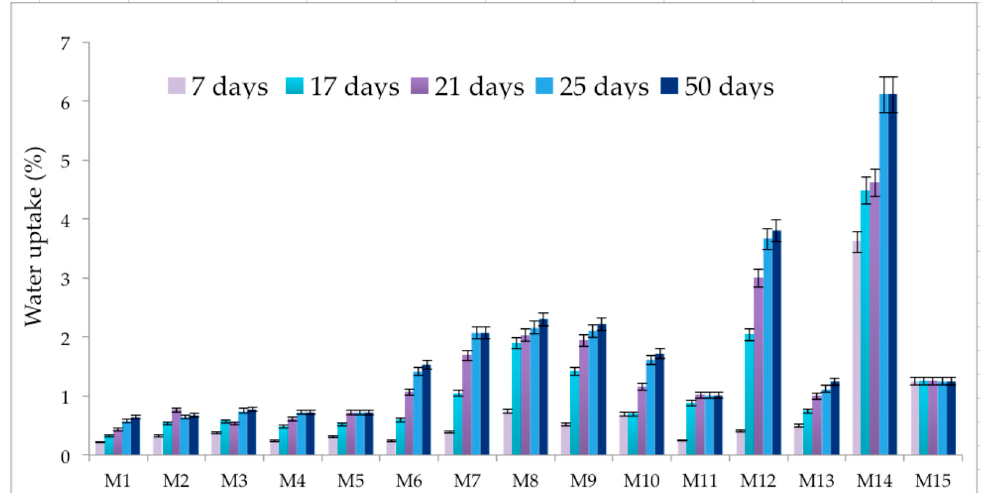
Figure 16. Wettability of the surface at different time-points.